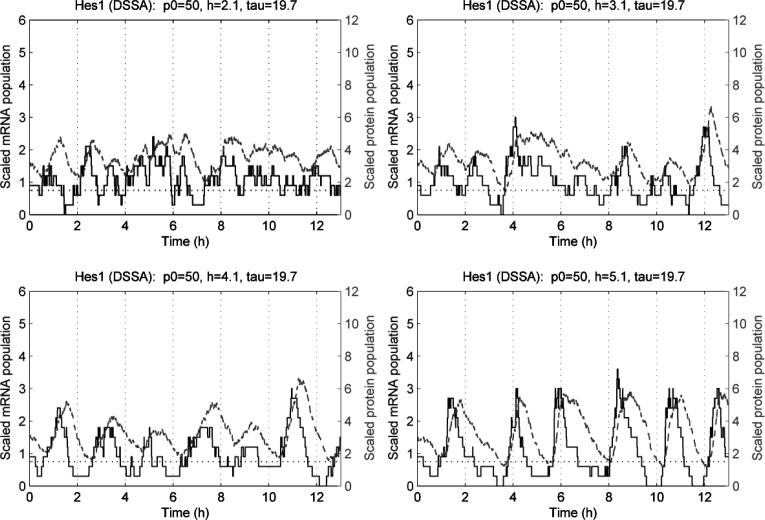
DSSA Simulations: Exploring the Effects of h
The horizontal dotted line marks P
0, mRNA is represented by the solid line, and protein by the dashed line.